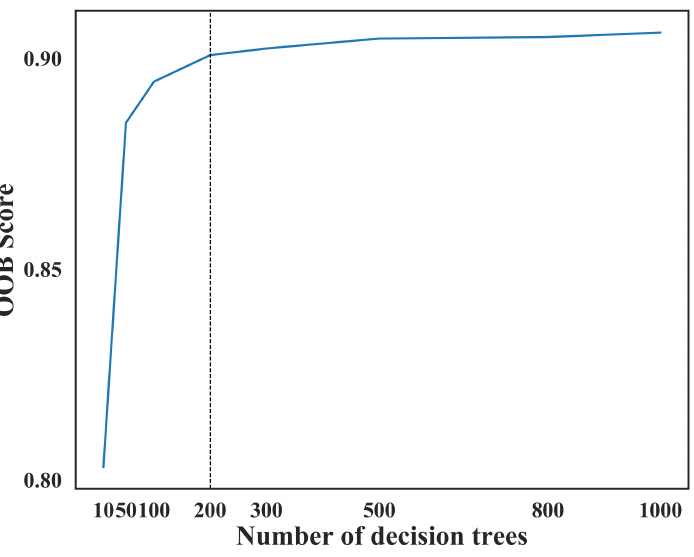
Figure 9. The parameter tuning in the RF model for the precipitation grades’